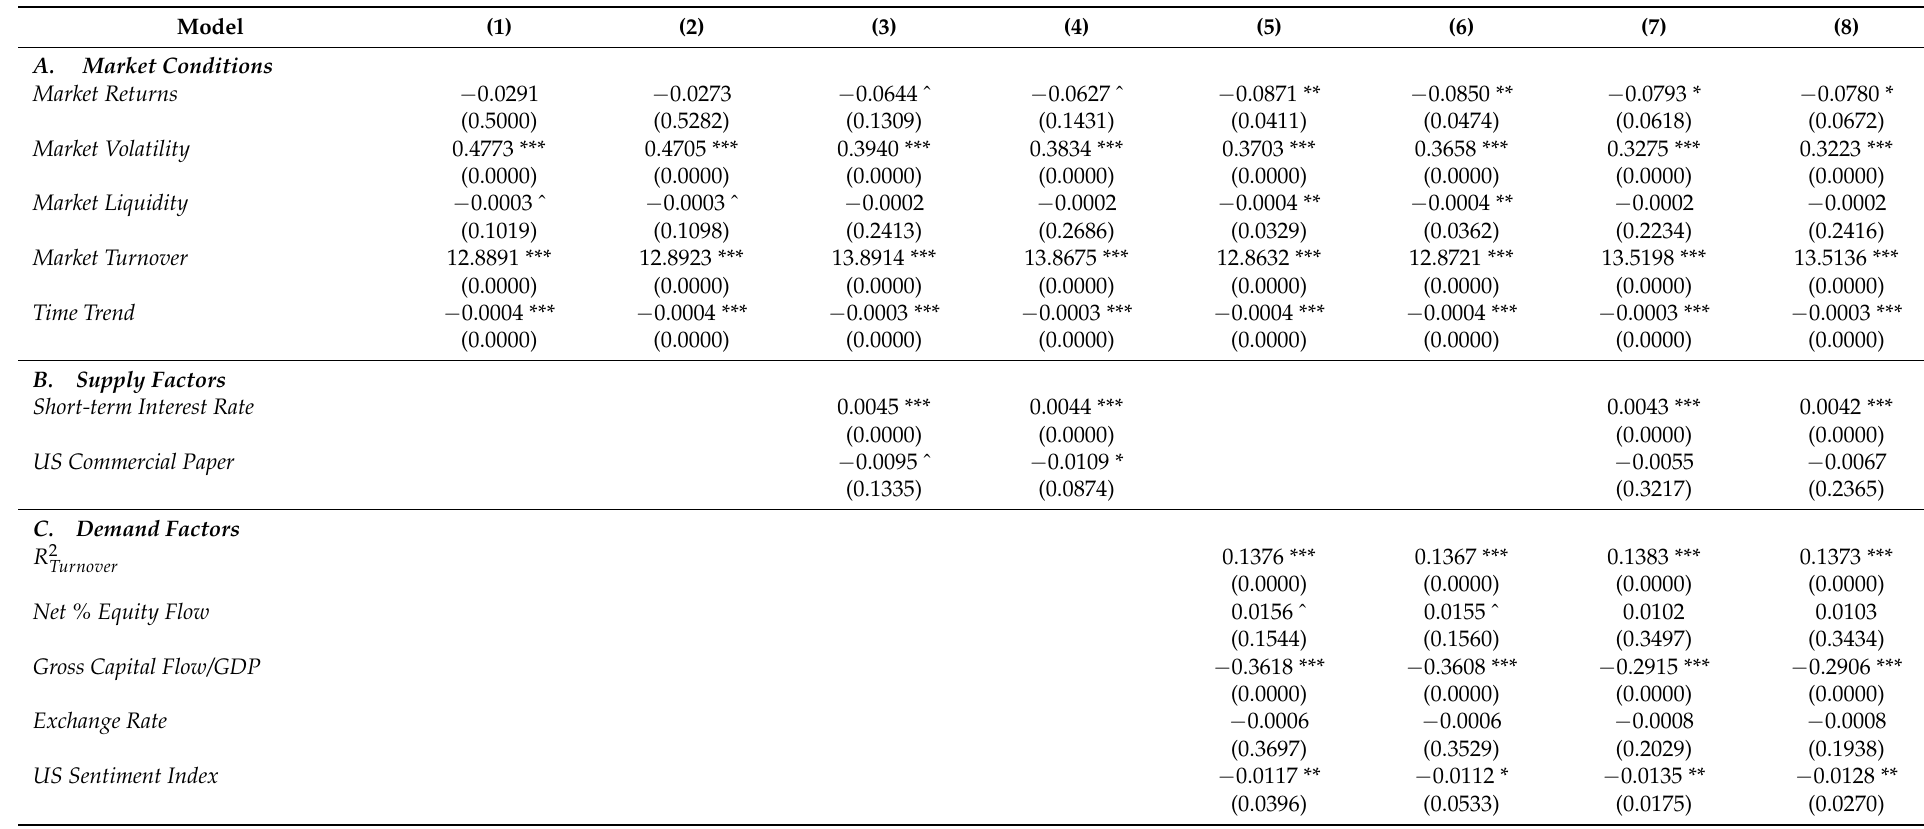
Table 4. Seemingly unrelated regressions of commonality in liquidity on sources of commonality. This table reports the results from SUR of 50 equations, representing the number of countries in our sample. All equations are jointly estimated for the period from January 1995 to December 2015. In each model, we restricted the coefficients to be equal across all equations. The dependent variable is a log-transformed form of the commonality in liquidity measure, R 2 . Full definitions of all variables are presented in Table A1 in Appendix A. Mean and Amihud medians of adjusted R 2 reported in the last two rows are taken from separate optimum least squares regressions of all